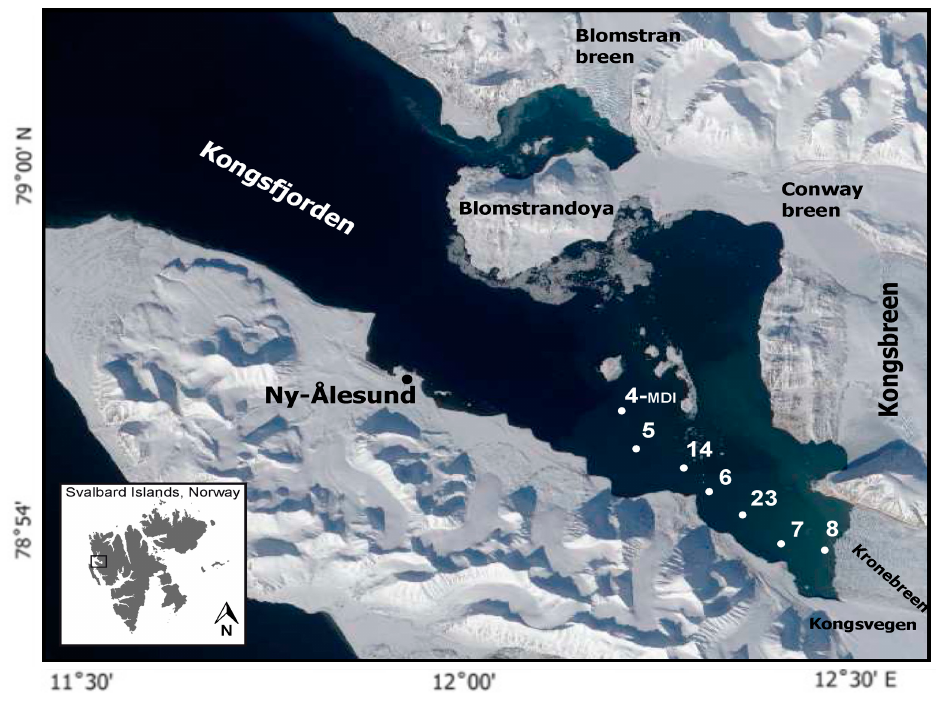
Figure 1. Location of the sampling stations along a transect in Kongsfjorden, Svalbard Islands (Arctic Norway).